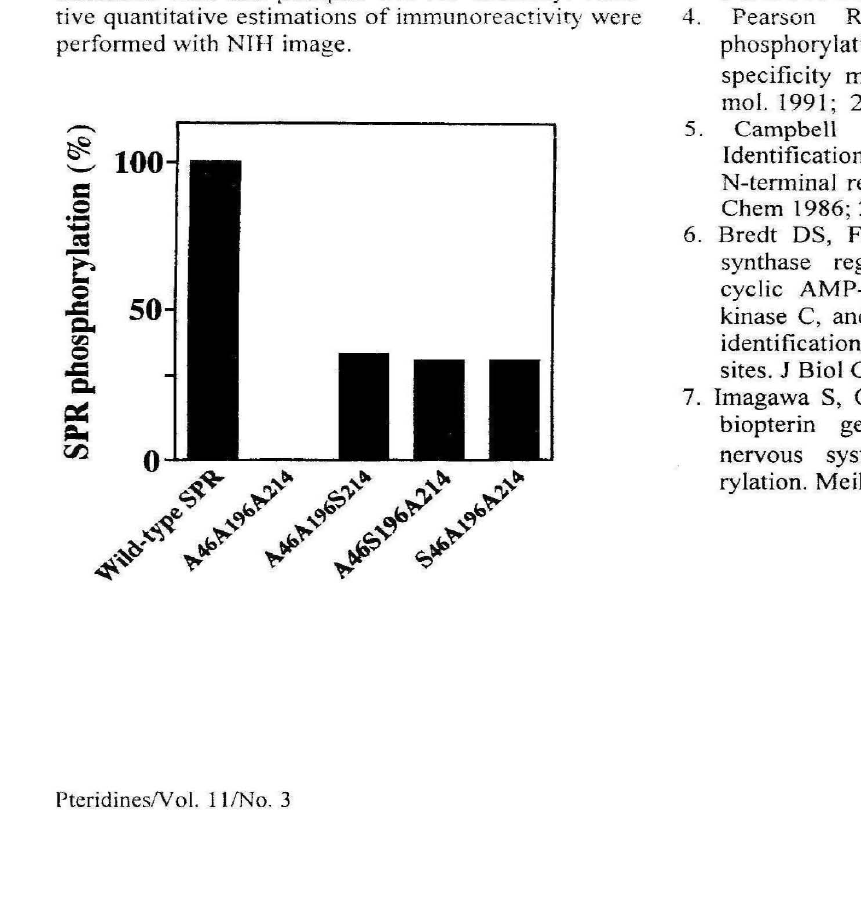
figure 2. Phosphorylation of point mutant SPRs by CaM KIt After SDS-PAGE of point mutant SPRs phosphorylated by CaM K!! , the proteins were electroblotted onto a PVDF membrane ClilU i;;;~c; nostained with anti-phospho Ser/Tilr antibody. Rela tive quantitative estimations of immunoreactivity were performed with NIH